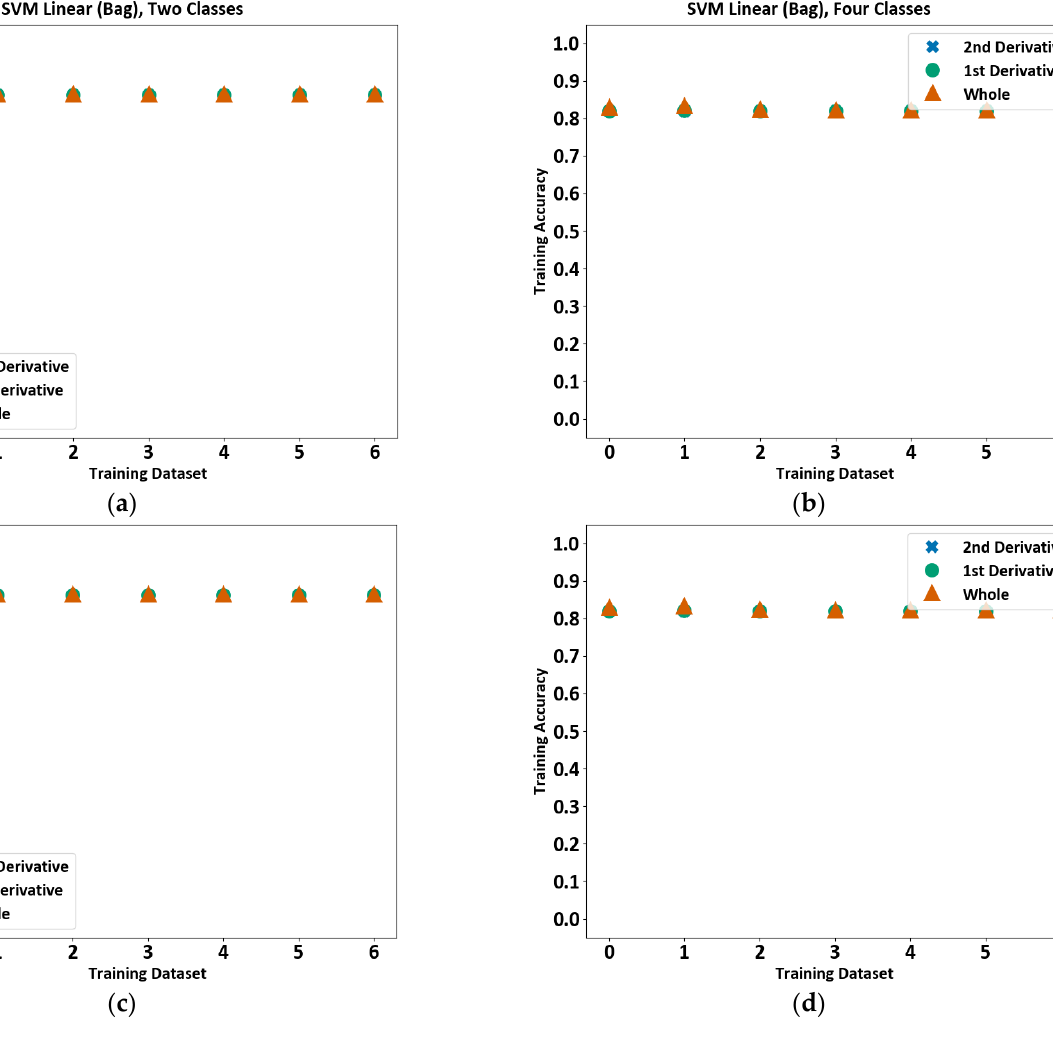
Figure 10. Support vector machine training accuracy for each file. The training accuracy for SVM linear using a bagging classifier for two-class model ( a ), SVM linear using a bagging classifier for four-class model ( b ), SVM linear for two-class model ( c ), and SVM linear for four-class model ( d ) are shown.